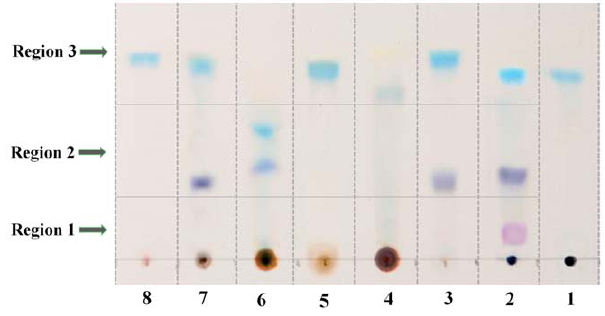
Figure 2. Identification of transformation products by TLC. The transformation samples were extracted with equal volume of ethyl acetate and concentrated by N 2 . 200 m L of the extracts were applied to the TLC plates (silica gel 60 F254), and then the TLC plates were resolved with a solvent mixture of dichloromethane-methanol (50:1, v/ v). The samples were designated as following: 1. Indigo (standard); 2. Products of indole transformation; 3. Products of 4-methylindole transformation; 4. Products of 5-methylindole transformation; 5. Products of 7-methylindole transformation; 6. Products of 5-methox- yindole transformation; 7. Products of 4-chloroindole transformation; 8. Products of 7-chloroindole transformation. The products with different R f values were indicated in three regions by the arrows.